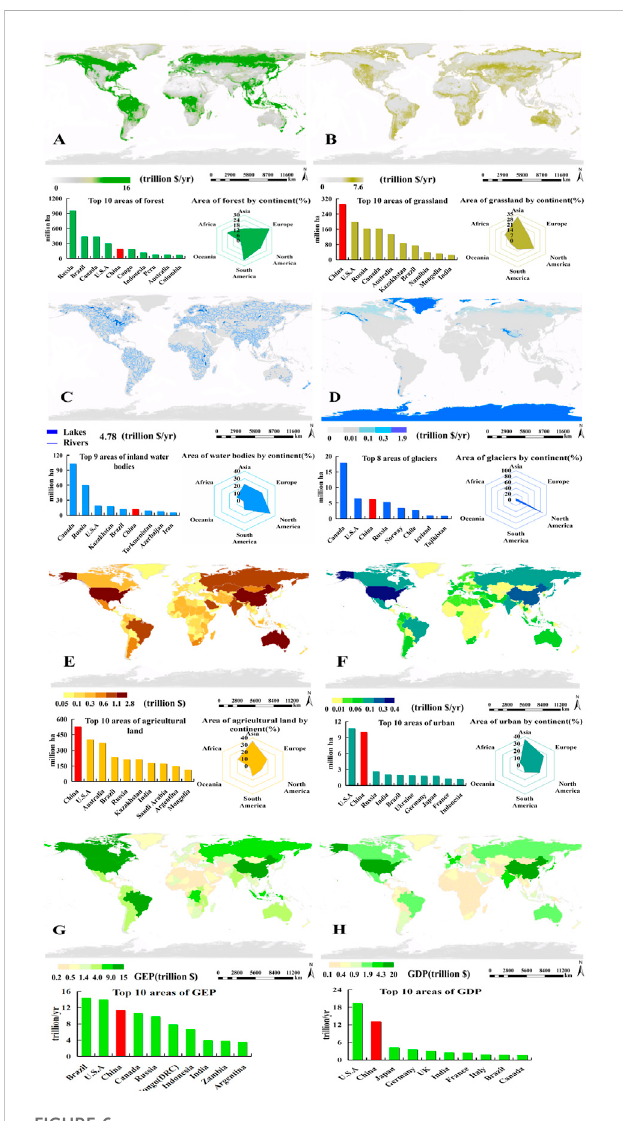
FIGURE 6 Distribution of GEP and GDP of major global ecosystems. Note: (A – F) represents the distribution of forest, grassland, wetland, glacier, farmland and urban ecosystems on all continents and major countries. (G) shows the main distribution of global GEP and (H) shows the maindistributionof global GDP. The global GEP accounting evaluation mainly refers to the relevant research literature on ecosystem service value(Costanzaetal.,1997;deGrootetal.,2012;Costanzaetal.,2014; Alamgir et al., 2016; Kuittinen et al., 2016; Kubiszewski et al., 2017; Kim et al., 2018; Chaudhary et al., 2019; Pham et al., 2019; Perrings et